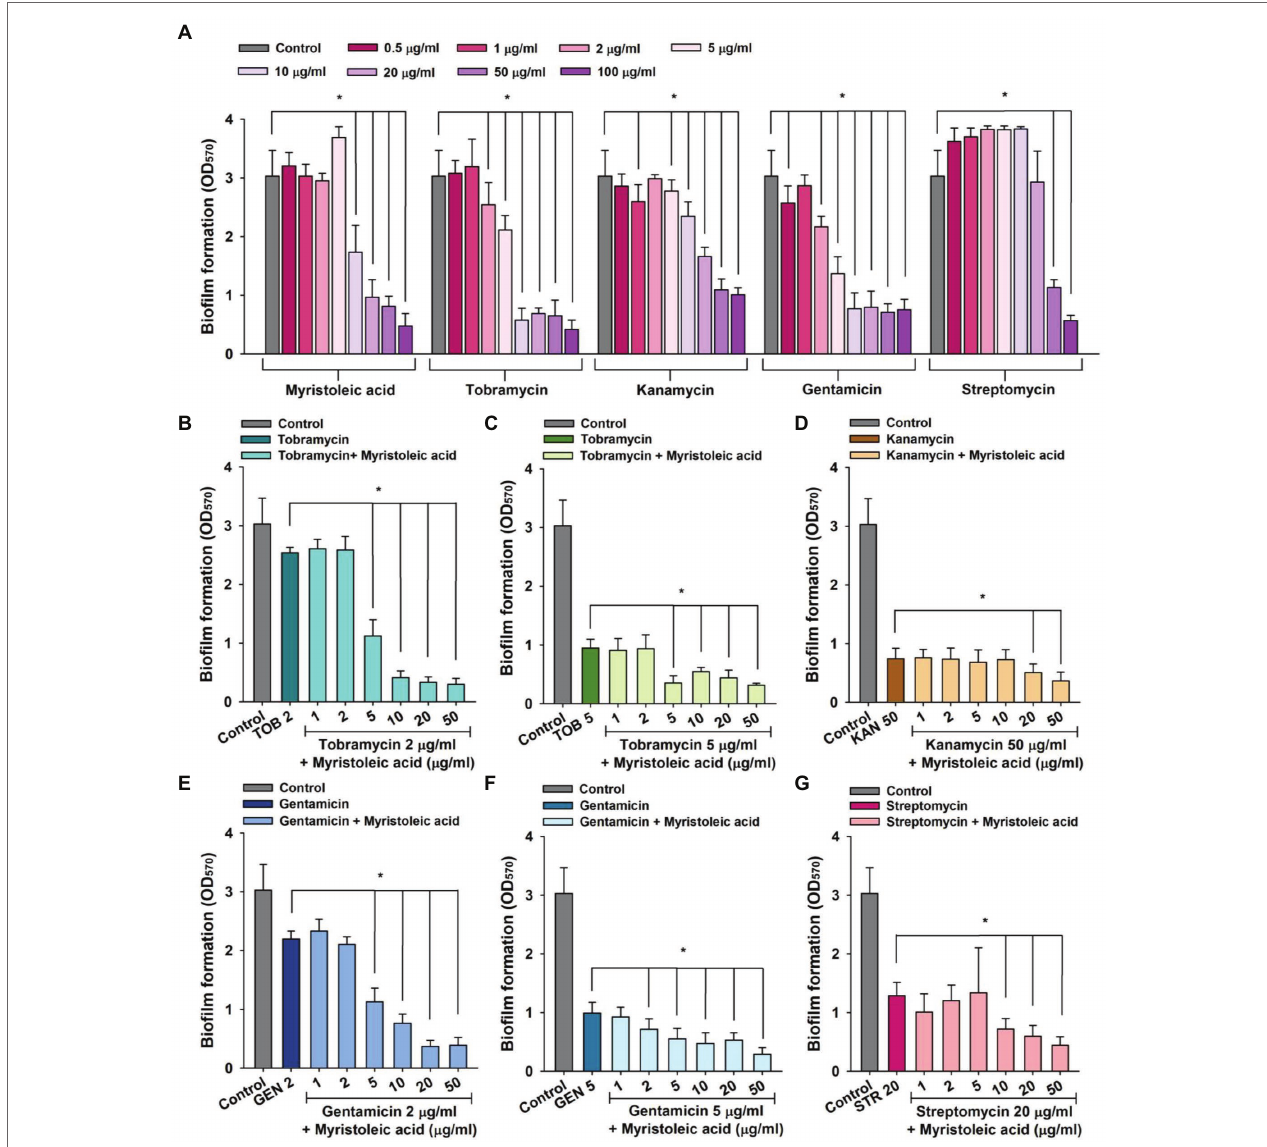
FIGURE 3 | Staphylococcus aureus biofilm inhibition by antibiotics in the presence or absence of fatty acids. Biofilm inhibitions by myristoleic acid, tobramycin, kanamycin, gentamicin, or streptomycin (A) were determined after incubation for 24 h in 96-well plates at 37 ° C under static conditions. Combinatorial antibiofilm activities of tobramycin (B,C) , kanamycin (D) , gentamicin (E,F) , or streptomycin (G) in the presence of myristoleic acid were measured after incubation under identical conditions. Error bars indicate SD. * p < 0.05 vs. untreated controls (A) . * p < 0.05 vs. antibiotic-treated controls (B–G) . TOB; tobramycin, KAN; kanamycin, GEN; gentamicin, STR; streptomycin, Control; untreated